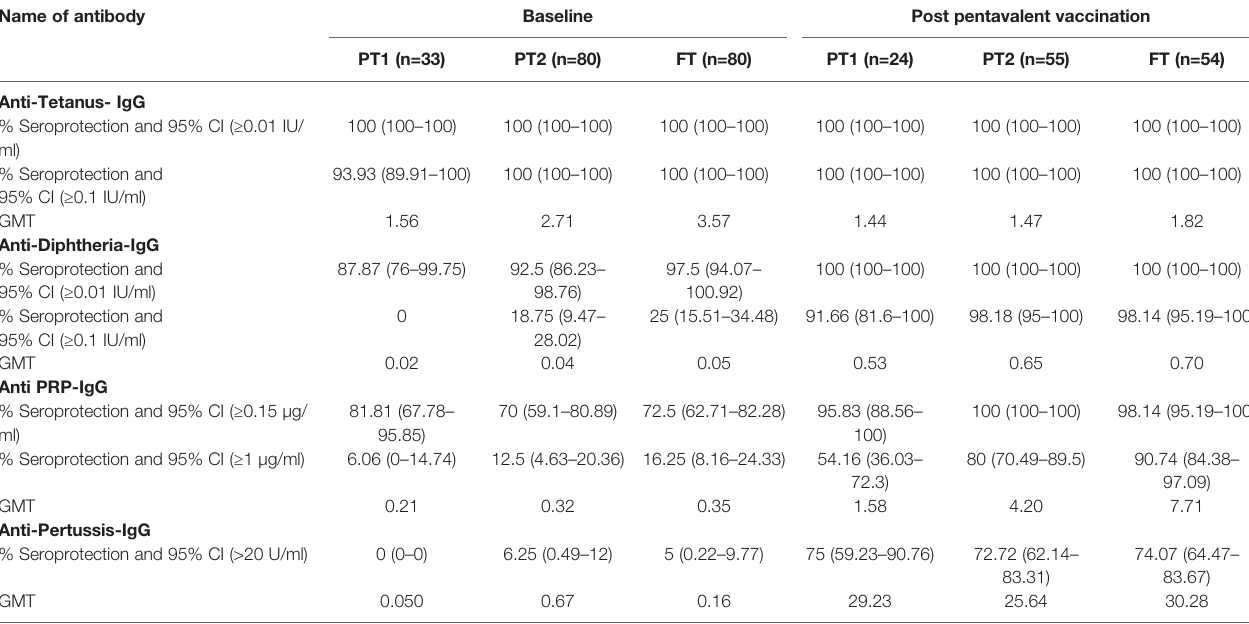
TABLE 2 | Pre and post pentavalent vaccination antibody titres against tetanus, diphtheria toxoid, Haemophilus in fl uenza B and Bordetella pertussis . Name of